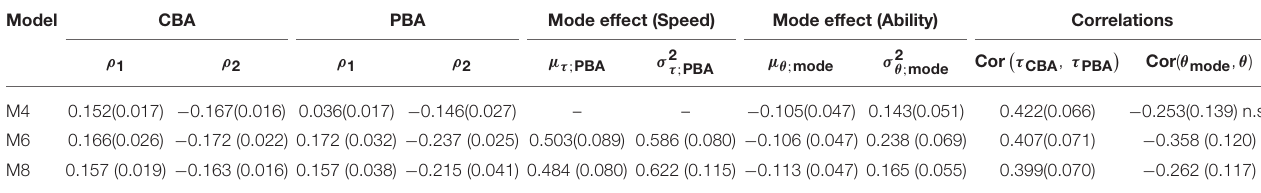
TABLE 6 | Estimates of selected model parameters of the combined B-GLIRT interaction model for CBA and PBA data (see Figure 6 ). Model CBA PBA Mode effect (Speed) Mode effect (Ability)